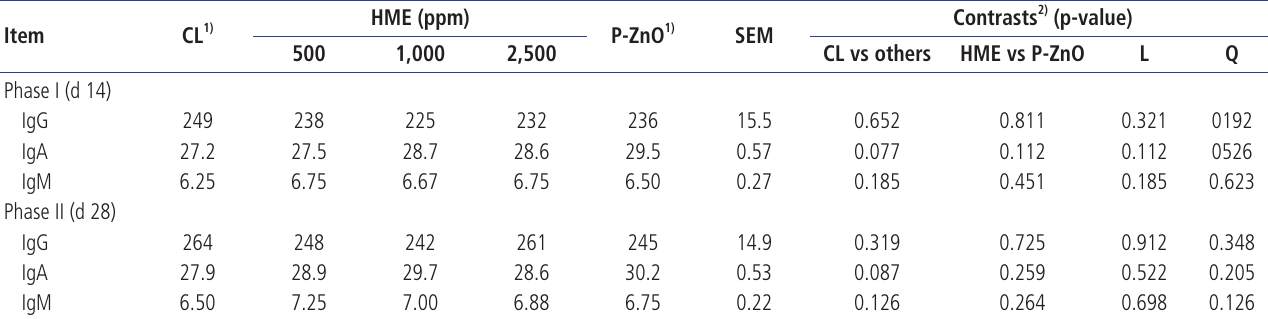
Table 4. Effects of different ZnO sources on the serum immunoglobulins (mg/dL) in weanling pigs